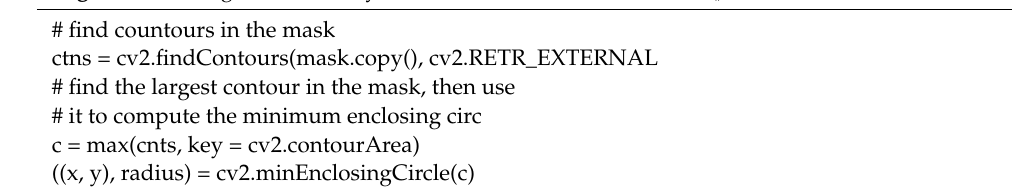
Algorithm 3. Fragment of the Python code: function findContours().